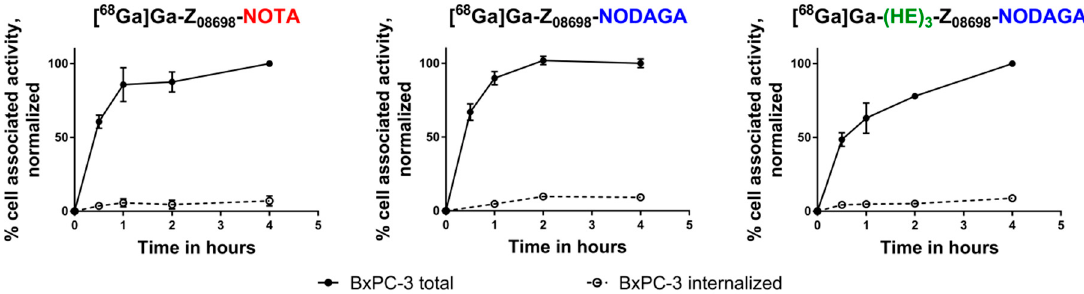
Figure 2. Cellular processing in BxPC-3 cells. Cells were continuously incubated with 0.1 nM of labeled construct at 37 °C. Error bars may not be visible because they are smaller than the curve symbols.